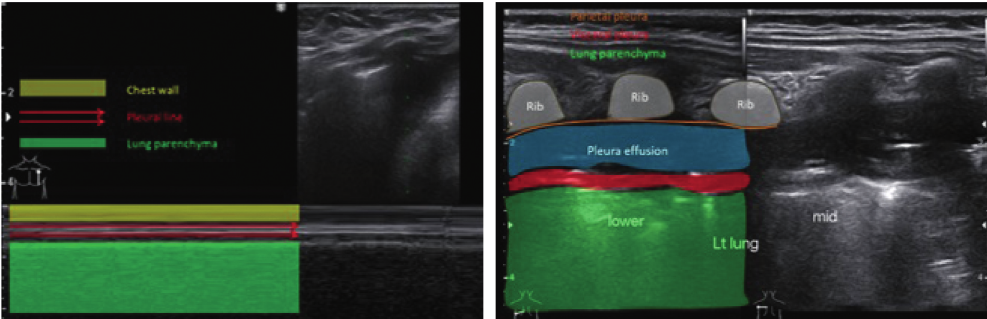
Figure 4: LUS left anterior using M-mode showing no pneumothorax and posterior lower and middle using B-mode: pleural effusion (transudate), pleural irregular thickening, and heterogeneous parenchymal echo texture.